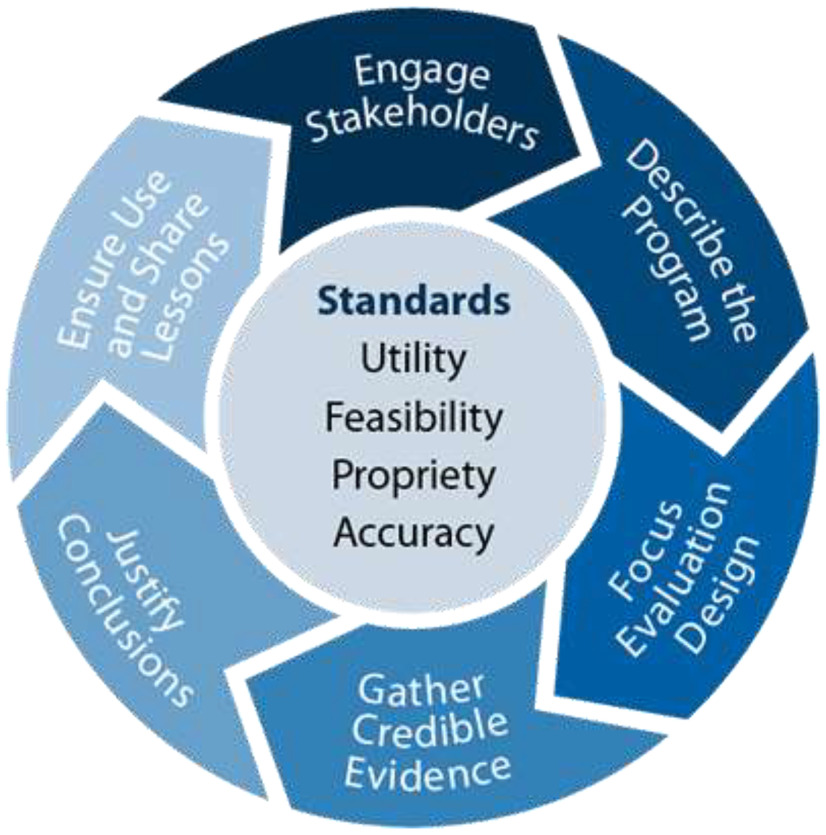
Centers for Disease Control and Prevention Framework for Evaluation in Public Health17